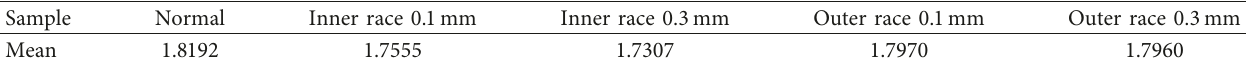
Table 4: Mean values of parameter α .